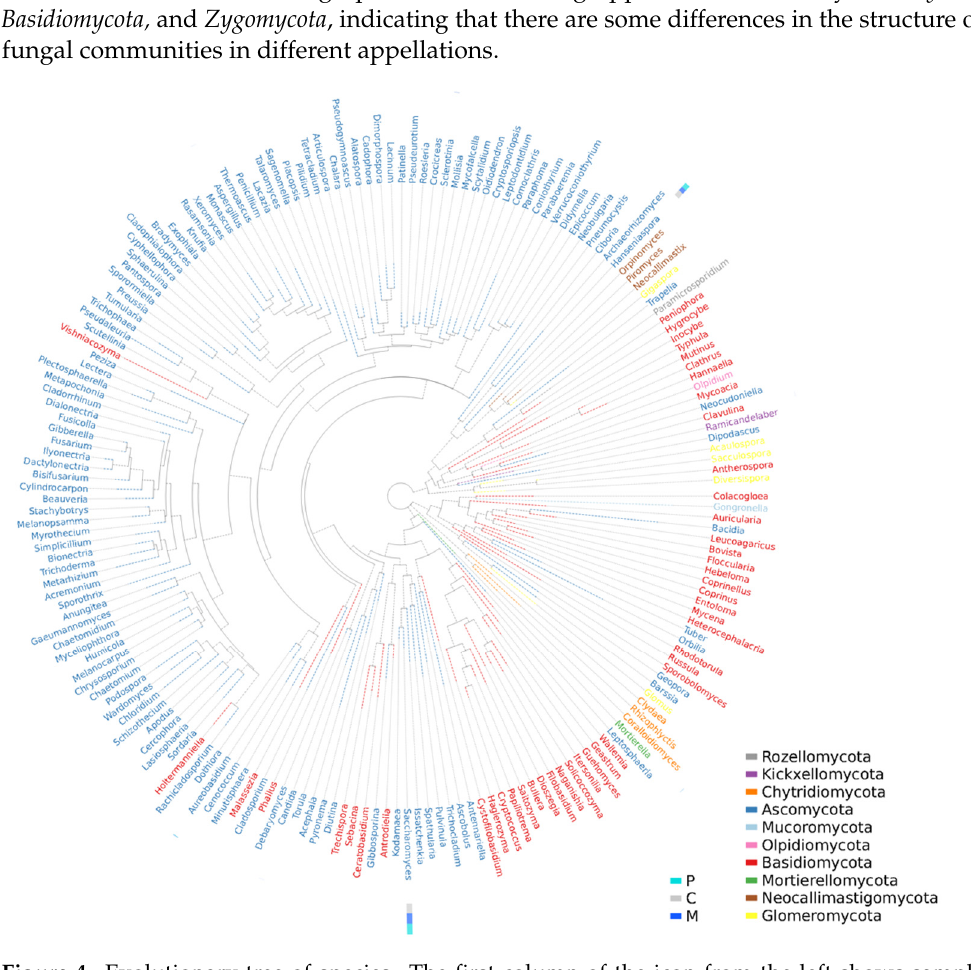
Figure 4. Evolutionary tree of species. The first column of the icon from the left shows sample information, and the second column shows the phylum level corresponding to the classification of the sample genus. The outer circle of the evolutionary tree offers the relative abundance of each genus in the different samples. The length of the color block represents the level of relative abundance.